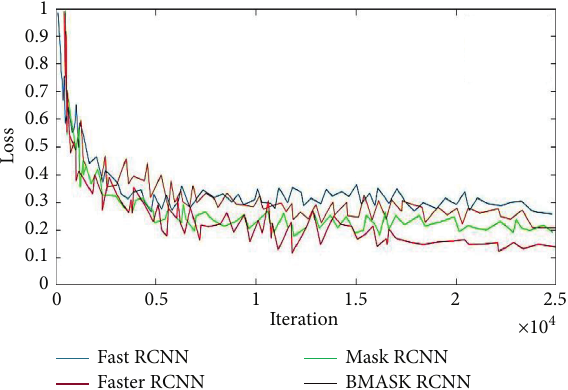
Figure 8: Curve comparative chart of loss iteration.